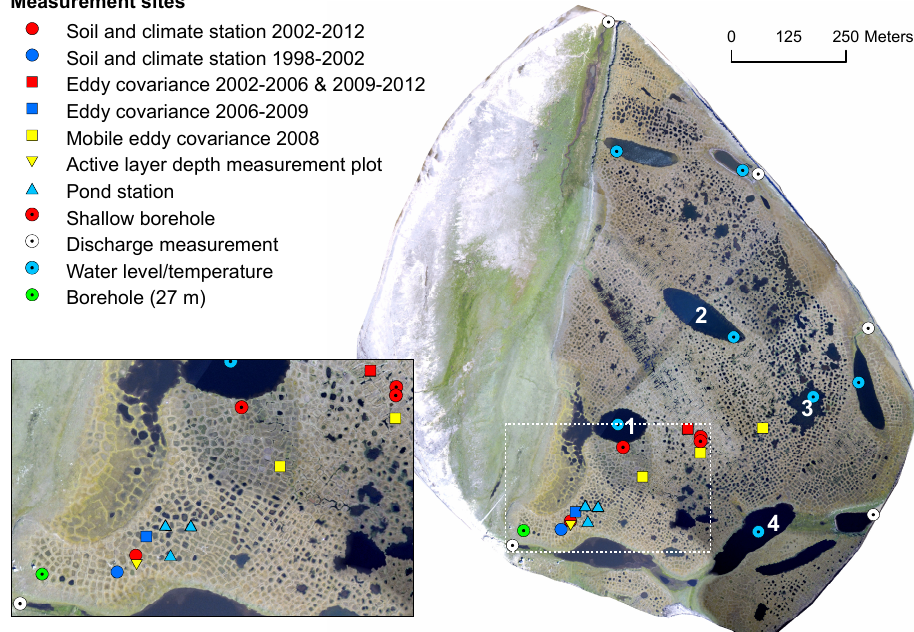
Fig. 2. Measurement sites on Samoylov Island since 1998. Long-term water level/temperature measurement stations have been installed in the four thermokarst lakes since